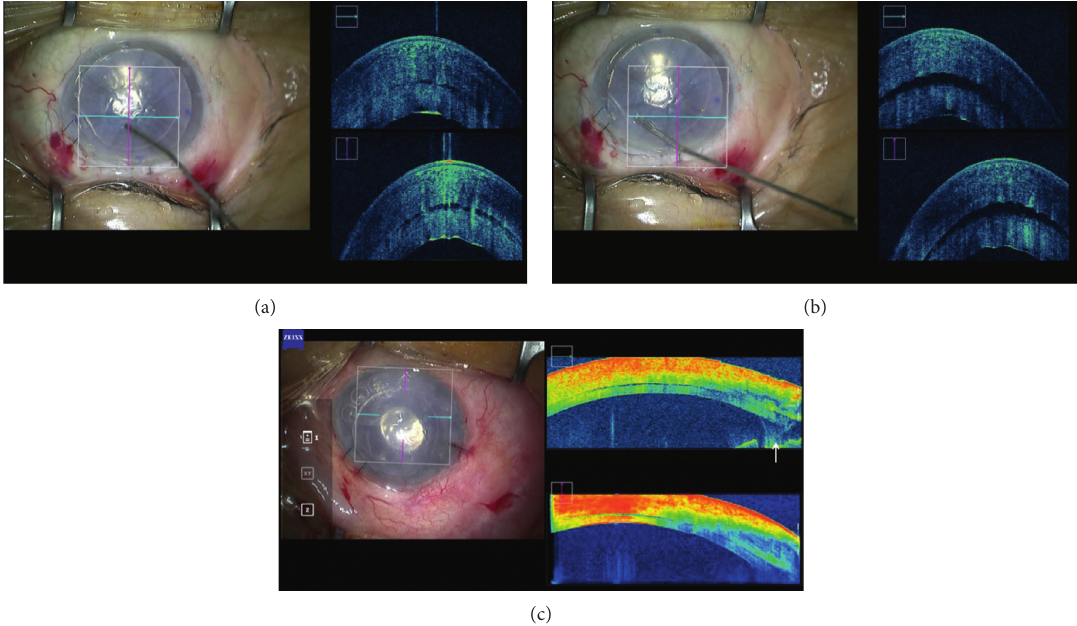
Figure 3: Residual interface space between the DSAEK graft and the host cornea. (a) Before corneal massage, a slight interface space between the DSAEK graft and the host cornea was observed. (b) Immediately after the corneal massage, the residual interface space widened. (c) DSAEK for advanced bullous keratopathy after multiple surgeries. Severe opacities in the cornea disturbed visualisation in the anterior chamber. MIOCT displayed a wide peripheral anterior synechia and a vitreous strand (arrow) touching the DSAEK graft.